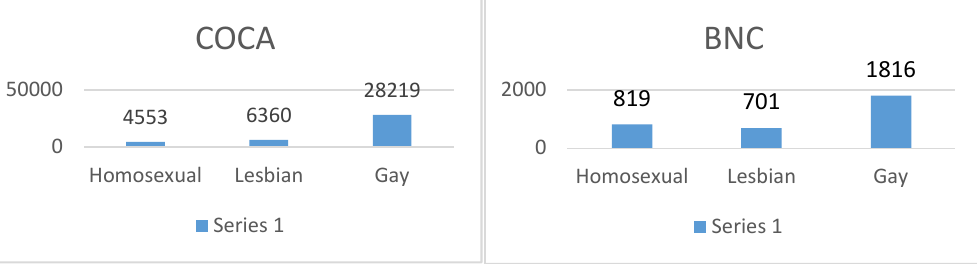
Fig. 1 Homosexual, Lesbian, and Gay in COCA and